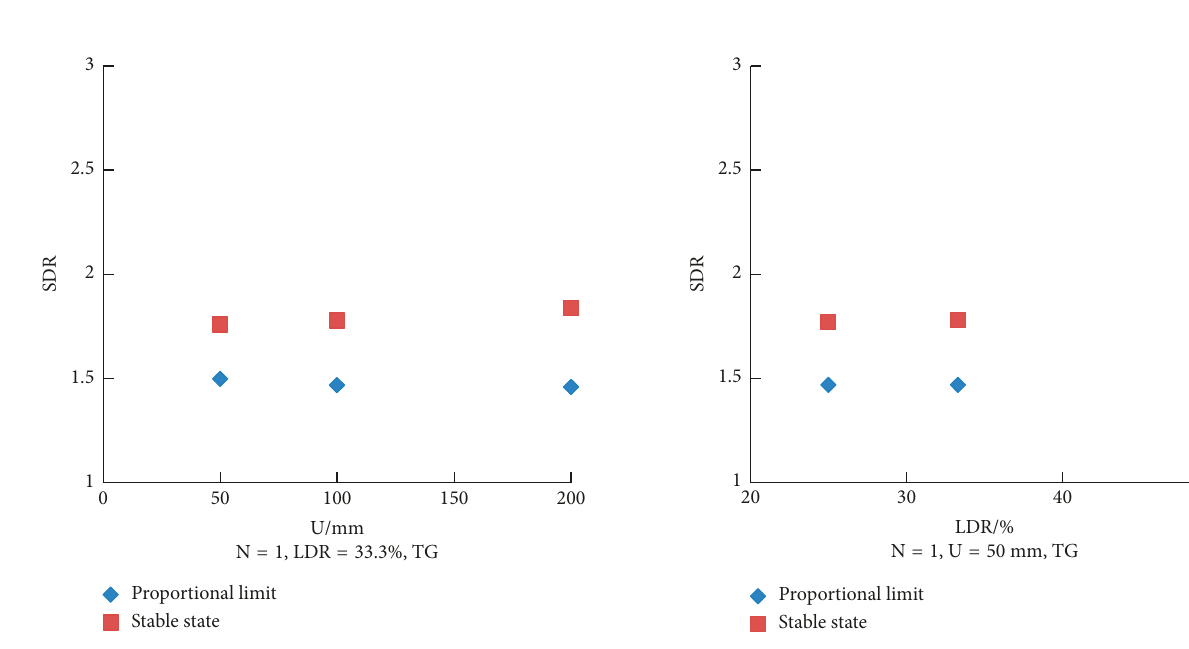
50mm, H 150mm, and (cid:30) (cid:30)